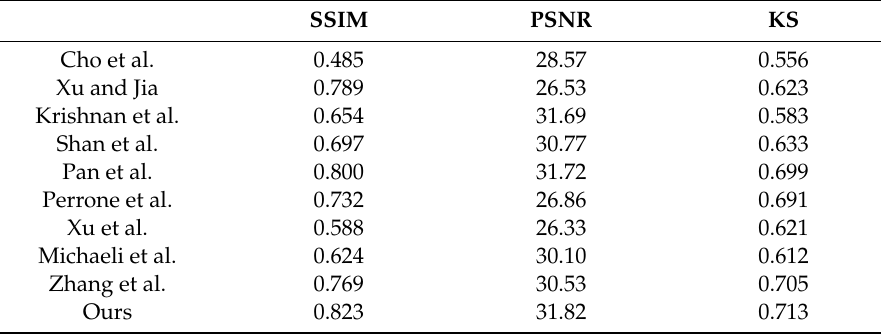
Figure 7. The deblurring results of Levin’s dataset. Table 1. Quantitative comparison of the deblurring results in Figure